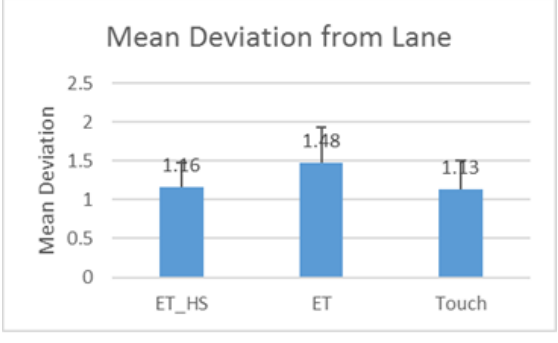
Figure 14. Comparing Driving Performance in terms of mean deviation.